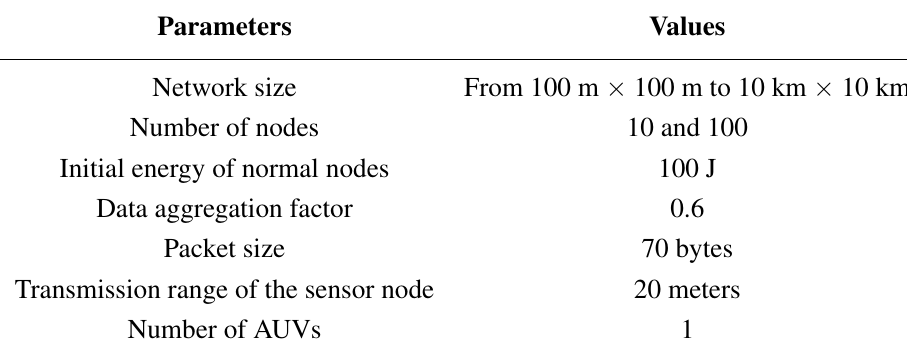
Table 2. We use the following metrics for the performance evaluation. Table 2. Parameters used in the